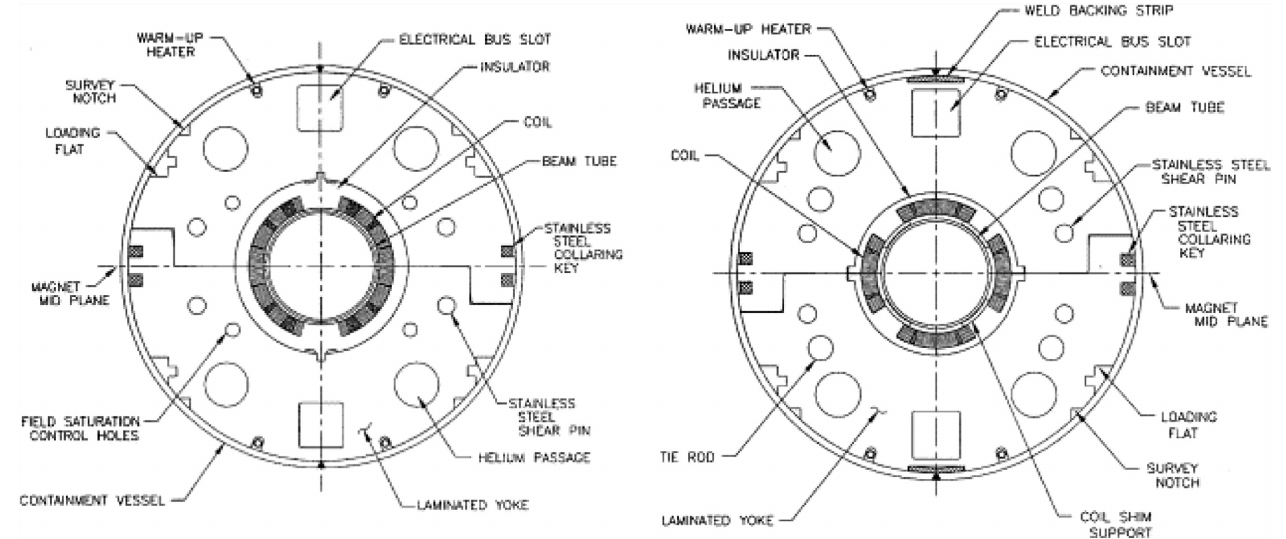
FIG. 1. The left plot shows the cross-section of the main dipole magnet. The right plot shows the cross section of the main quadrupole